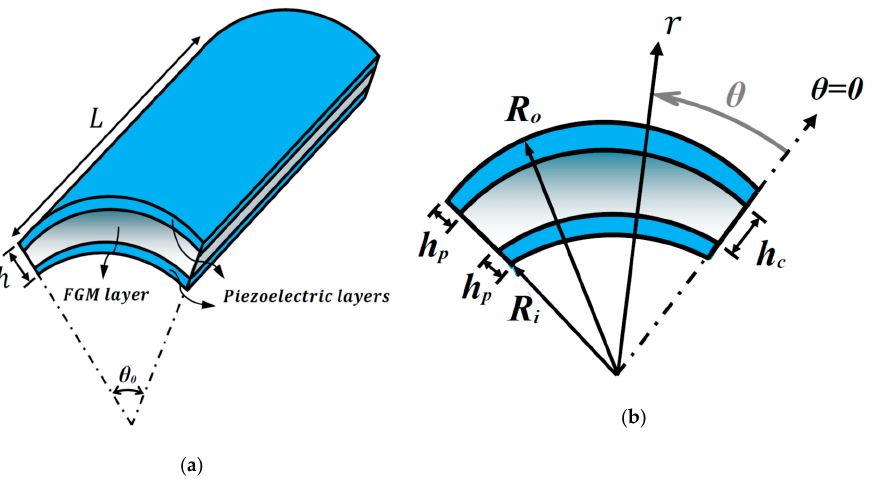
Figure 1. ( a ) and ( b ): Geometry of the FG cylindrical panels embedded in piezoelectric layers.